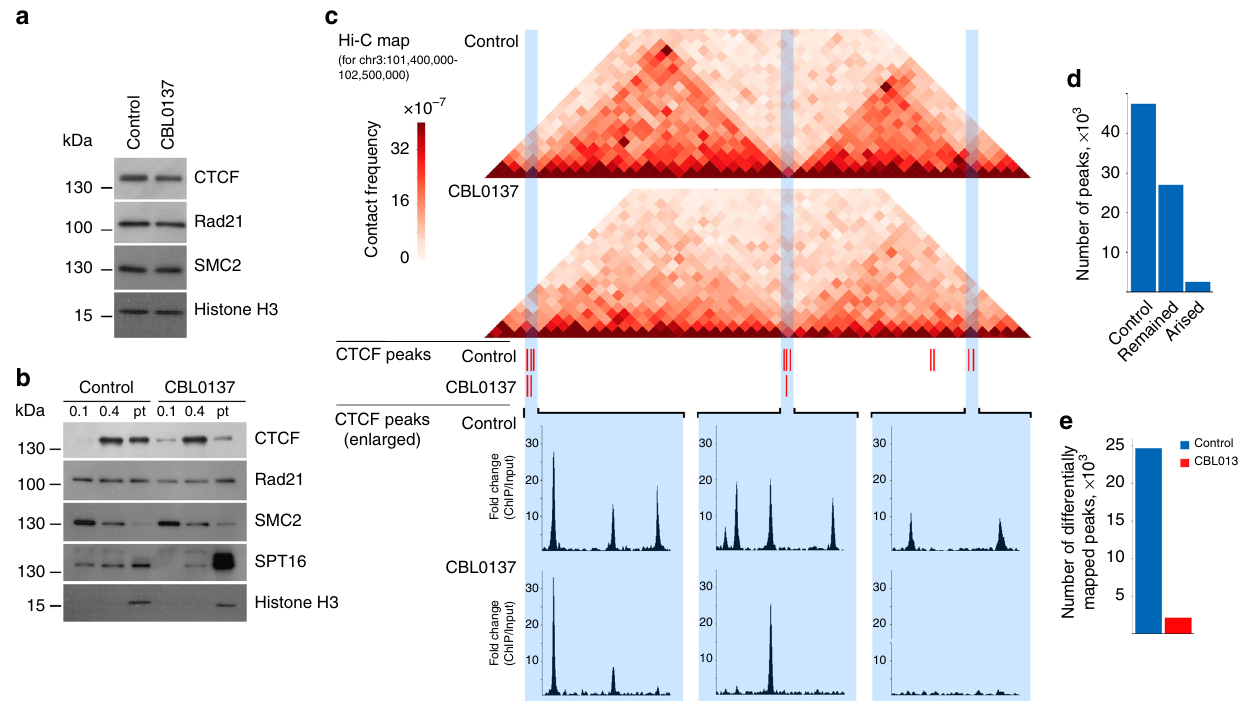
Fig. 6 CBL0137 induces partial dissociation of CTCF from its binding sites. a Western blot analysis of CTCF, Rad21 (cohesin subunit), and SMC2 (condensin subunit) in nuclear extracts prepared from control and CBL0137-treated (3 µ M, 6 h) HT1080 cells. Histone H3 was used as a loading control. b Western blot analysis of CTCF, Rad21, SMC2, SPT16 (FACT subunit), and histone H3 in different chromatin fractions from control and CBL0137-treated (3 µ M, 6 h) HT1080 cells prepared by sequential extraction with 0.1 and 0.4 M NaCl. Pellet (Pt): insoluble chromatin fraction. c Representative 1.1 Mb-long genomic segment from chromosome 3 containing two distinct chromatin loop domains bordered by CTCF binding sites in control cells. Corresponding Hi- C maps, CTCF peaks determined using the PePr computational approach[43], and an enlarged view of the particular groups of CTCF peaks are shown for control and CBL0137-treated HT1080 cells. d Bar plots showing the total number of CTCF peaks mapped by PePr in intact HT1080 cells, preserved after CBL0137 treatment, and the newly formed CTCF peaks in CBL0137-treated cells. e Bar plots showing the number of CTCF differential binding sites identi fi ed in control and CBL0137-treated HT1080 cells. Analysis of differential binding sites was performed using PePr43, which showed the number of peaks mapped only in one of the two samples (either control or CBL0137-treated). Source data of Fig. 6a, b are provided in a Source Data fi